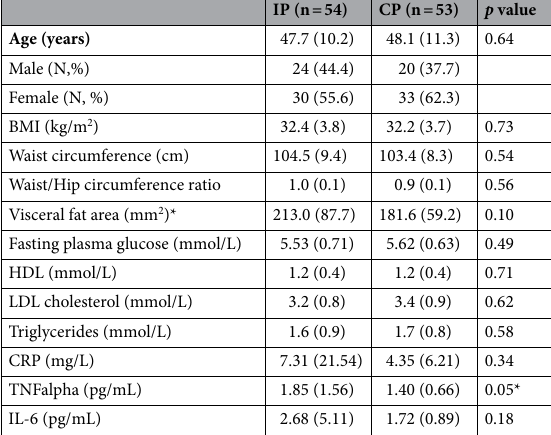
Table 1. Baseline subject characteristics for the FAS population. Mean +/− SD; BMI: Body mass index; * p < 0.05 between IP and CP; Distribution in men and women was equivalent in both groups ( p =